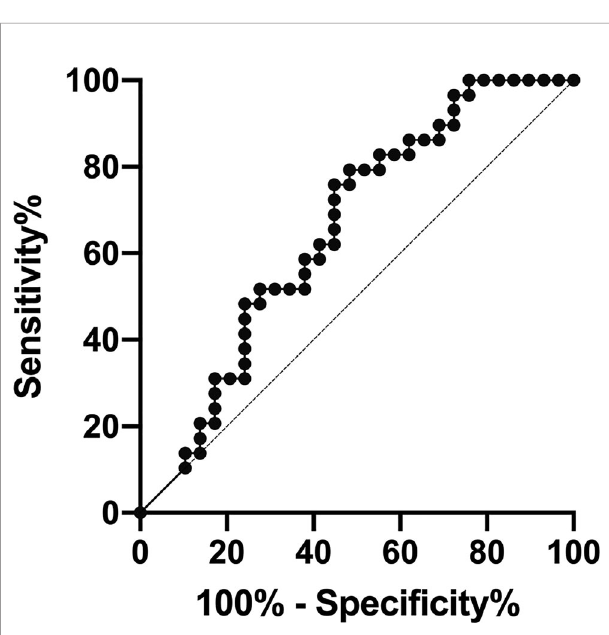
FIGURE 4 | Receiver operating characteristic (ROC) curve analysis of the predictive capacity of heparin-binding protein (HBP) to distinguish between adult-onset Still ’ s disease (AOSD) and